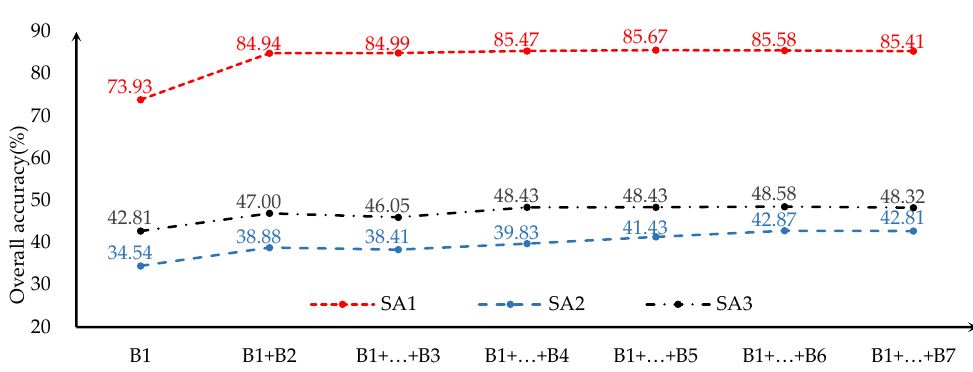
Figure A1. Relationship between accumulated multispectral bands and overall accuracy.